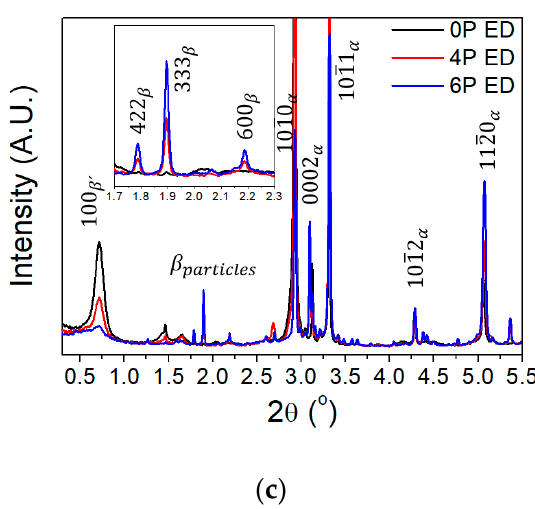
Figure 11. ( a ) Axial and radial diffraction patterns as a function of 2 θ obtained by integration of the Debye-Scherrer diffraction rings for the as-extruded alloy. ( b ) Radial diffraction patterns as a function of 2 θ obtained by integration of the Debye-Scherrer diffraction rings for the as-extruded alloy and after ECAP processing. ( c ) Axial diffraction patterns as a function of 2 θ obtained by integration of the Debye-Scherrer diffraction rings for the as-extruded alloy and after ECAP processing aged at 200 °C for 24 h.